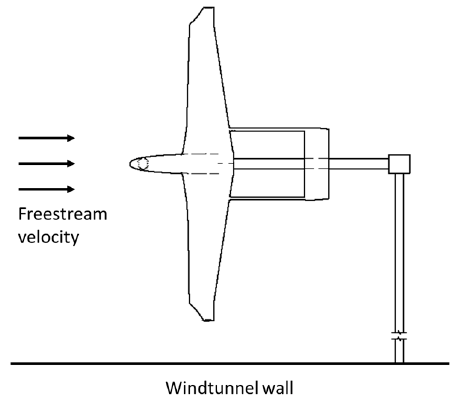
Figure 3. Schematic of the experimental setup and arrangement of the measurement devices inside the test section.